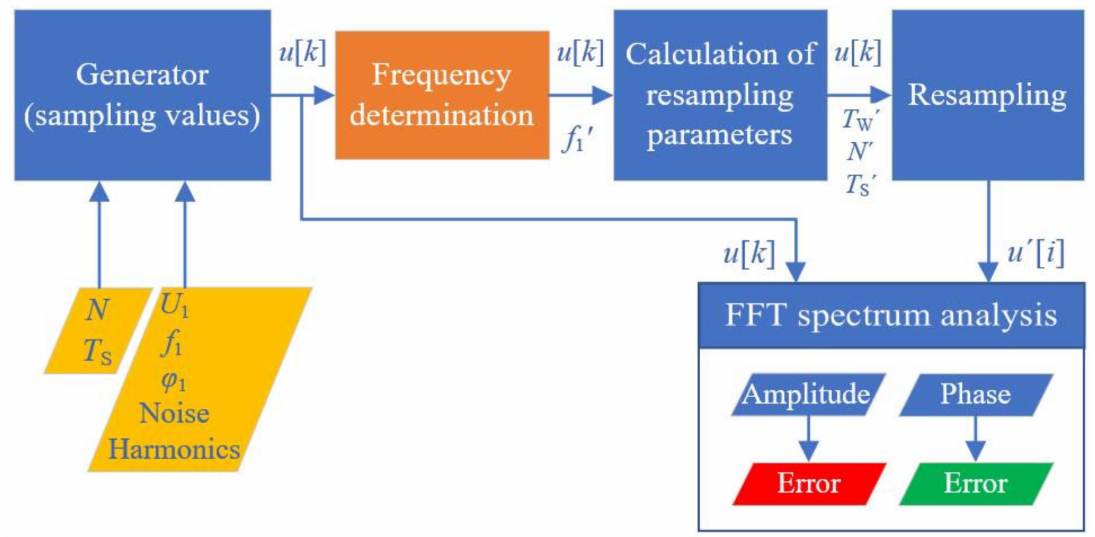
Figure 3. Scheme of the resampling